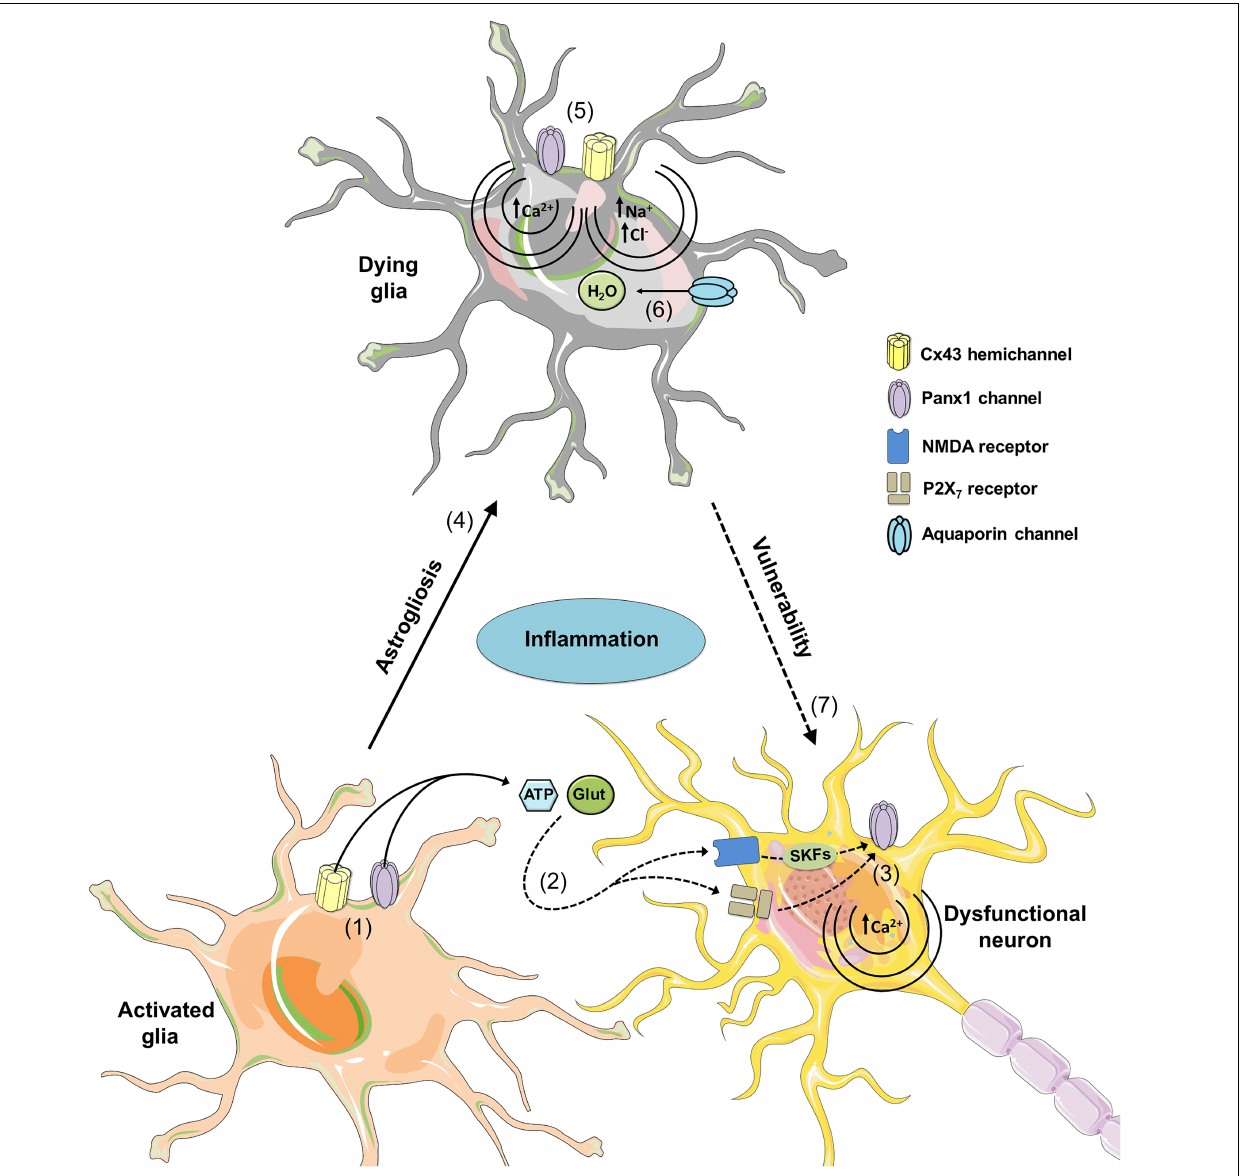
FIGURE 4 | Possible roles of glial hemichannels and pannexons during neuroinflammation. At early stages of different neurodegenerative diseases, increased inflammation activates glial Cx43 hemichannels and Panx1 channels (1), resulting in the release of gliotransmitters (ATP and glutamate) and further stimulation of NMDA and P2X 7 receptors in neurons (2). NMDA and P2X 7 receptor activation possibly increases the opening of neuronal Panx1 channels through phosphorylation of Panx1 by Src family kinases (SFKs) and direct protein-to-protein interactions, respectively (3). The latter could affect [Ca 2 + ] i homeostasis leading to cell damage and further death. Uncontrolled activation of glial cells may result in reactive gliosis and subsequent damage by a mechanism that implicates the opening of hemichannels and pannexons (4). Specifically, permanent opening of Cx43 hemichannels and Panx1 channels could cause cell damage by different mechanisms. At one end, Ca 2 + entry via Cx43 hemichannels or Panx1 channels may activate phospholipase A 2 with the subsequent generation of arachidonic acid and activation of cyclooxygenase/lipoxygenase pathways, which consequently leads to elevated levels of free radicals, lipid peroxidation and plasma membrane breakdown (5). At